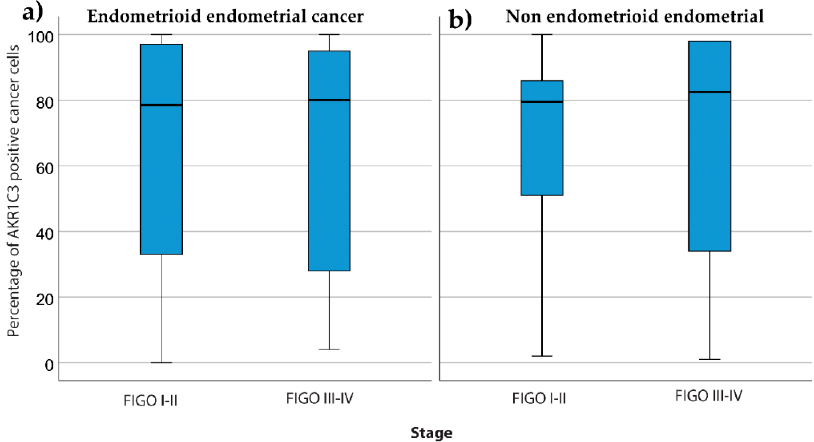
Figure 6. AKR1C3 distribution between patients with di ff erent FIGO stages. The box plots show AKR1C3 IHC expression (median, box from 25th to 75th percentiles, whiskers correspond to the 25th percentile minus 1.5 times IQR (interquartile range) and to the 75th percentile plus 1.5 IQR) for patients with di ff erent FIGO stages for endometrioid endometrial cancer ( a ) and nonendometrioid endometrial cancer ( b ).